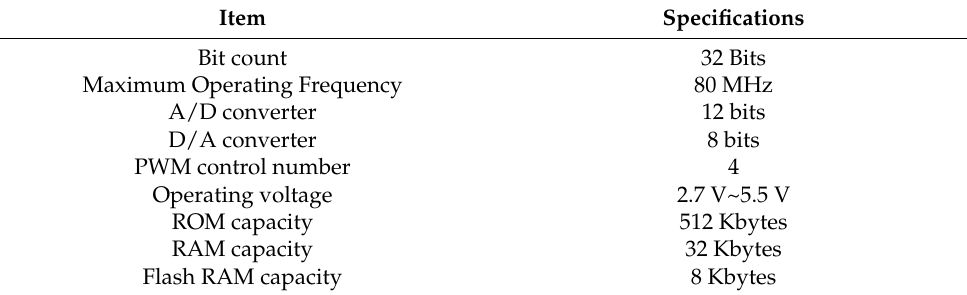
Table 6. Specifications of Micro-controller unit Renesas RX24T.